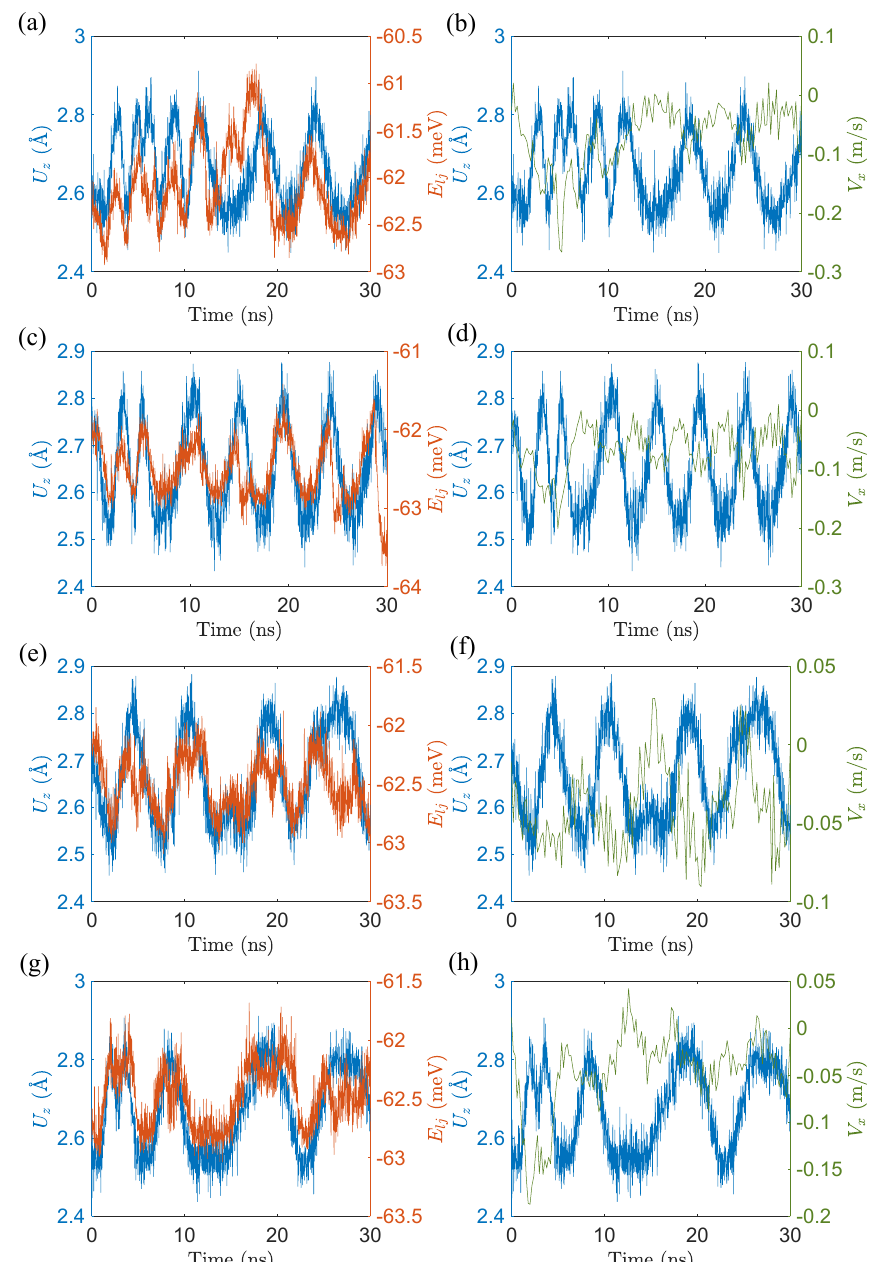
Figure 7. Variations of displacement U z , velocity V x of tail atom, and LJ potential energy E lj of the moiré pattern in GNRs under horizontal drag. ( a , b ) l x ∼ 9.2 nm, v d = 0.3 m/s and Z 0 = 17.5 Å; ( c , d ) l x ∼ 11.3 nm, v d = 0.4 m/s and Z 0 = 17.5 Å; ( e , f ) l x ∼ 20 nm, v d = 0.3 m/s and Z 0 = 12.5 Å; ( g , h ) l x ∼ 9.2 nm, v d = 0.4 m/s and Z 0 = 17.5 Å. All the GNRs exhibit peeling